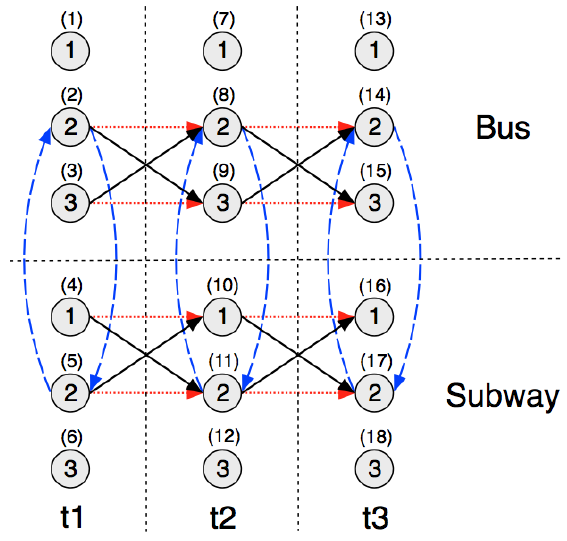
Figure 3. MAG T with composite vertices numerical